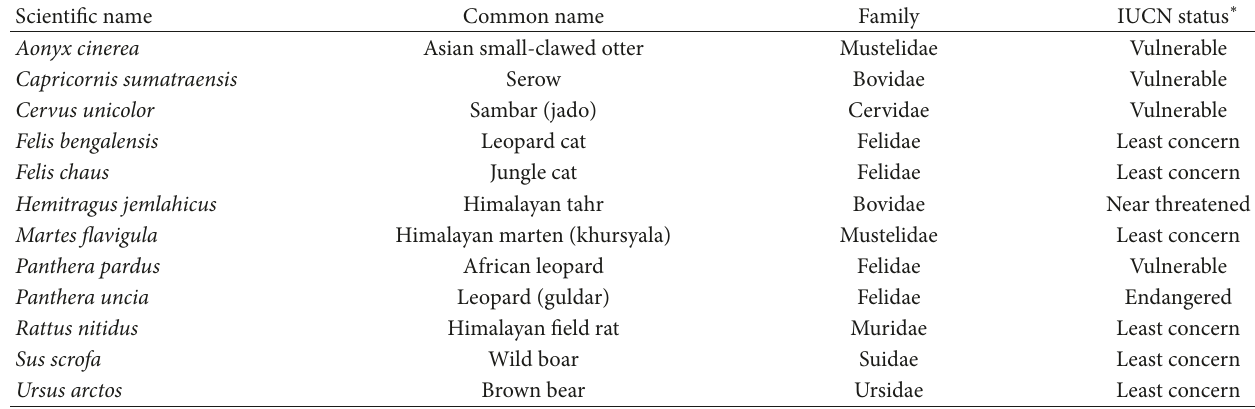
Table 5: List of sacred animal species (with IUCN conservation status) found in Hariyali Devi.